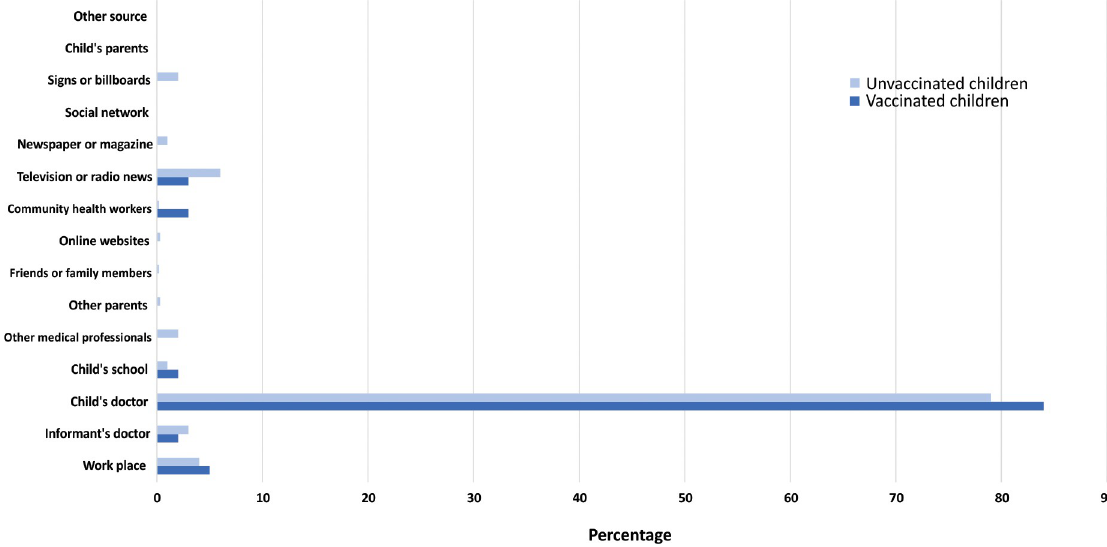
Fig 2. The most trusted source about influenza vaccine for